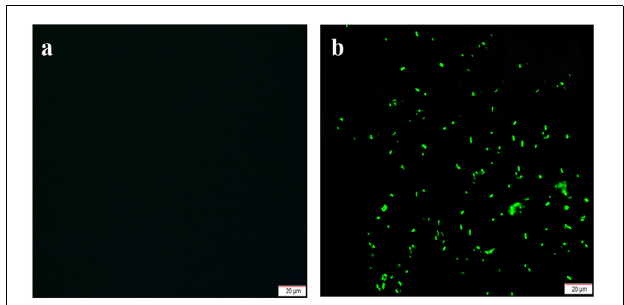
FIGURE 1 | Fluorescence microscopy detection of the green fluorescent protein (GFP)-tagged strain YL6-GFP [ a : original strain (Yangling 6, YL6); b : marked strain